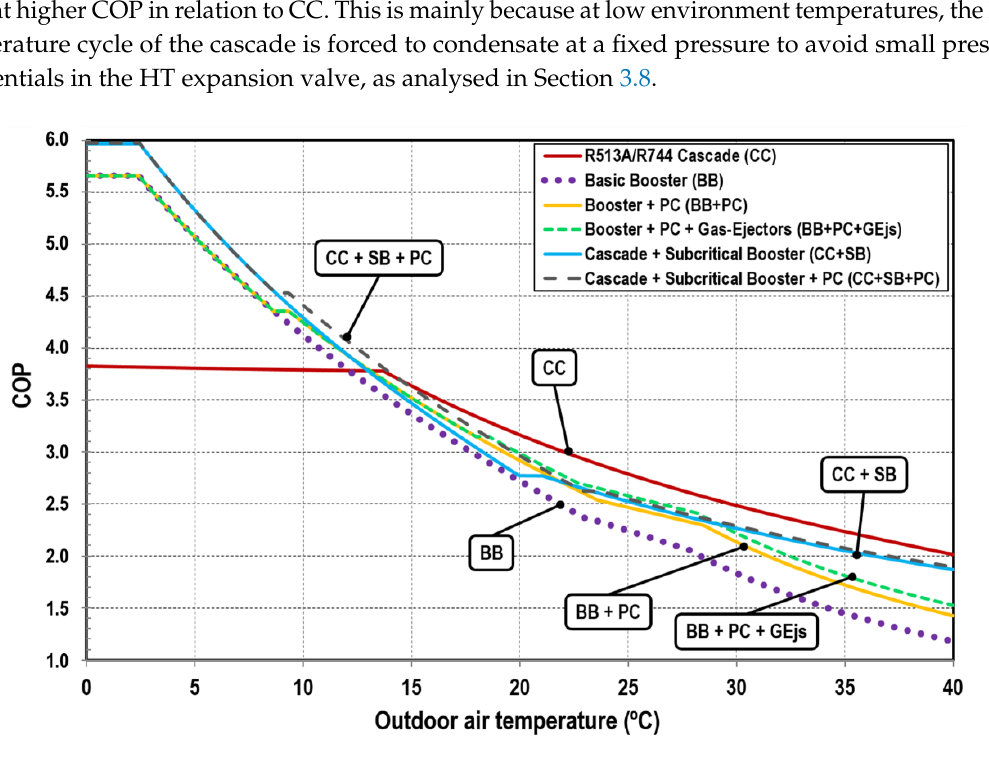
Figure 9. Systems’ COP at different environment temperatures.